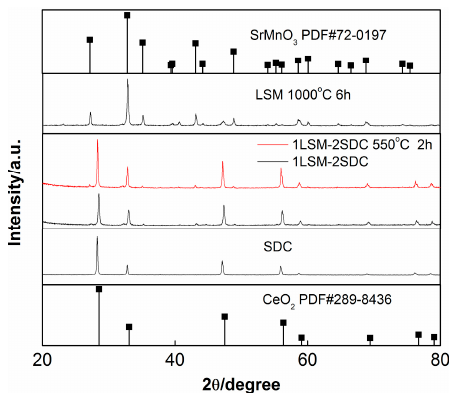
Figure 1. XRD patterns of LSM (La 0.1 Sr 0.9 MnO 3 −δ ), SDC (Ce 0.8 Sm 0.2 O 2 −δ ) and LSM-SDC composite before and after calciation treatment.